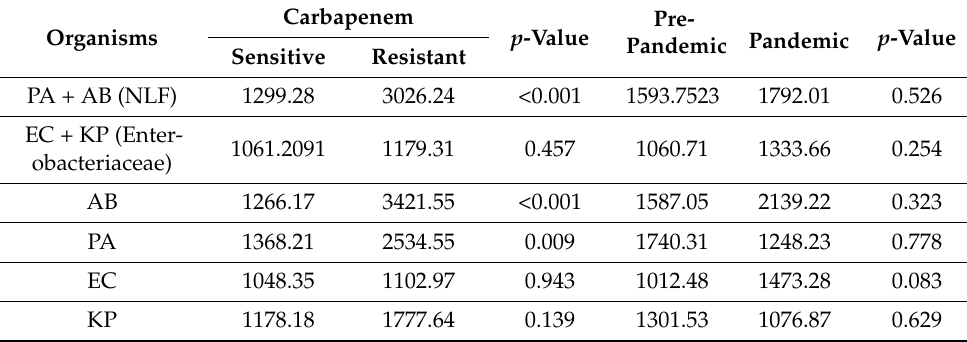
Table 2. Comparison of various hospital median costs among four groups by carbapenem status, organism’s category, and pre-pandemic versus pandemic (in 2021